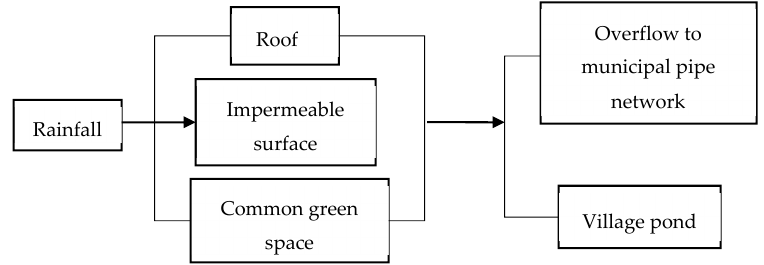
Figure 4. Drainage path of runoff in the traditional development model.